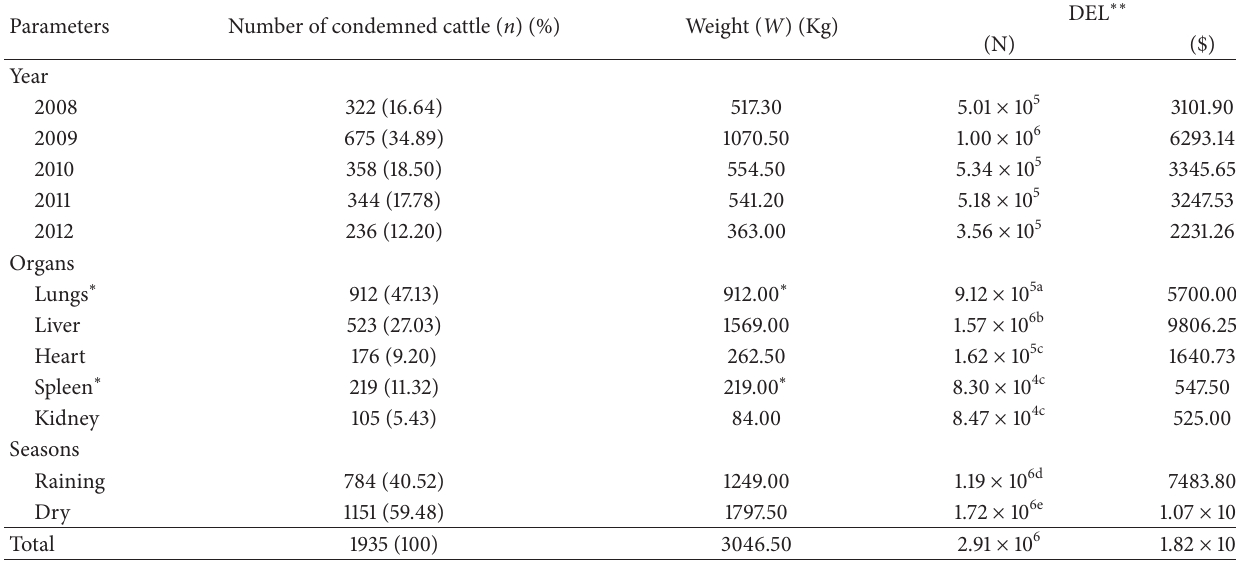
Table 2: Direct economic loss from condemnation of edible organs as a result of detection of tubercle lesion in cattle slaughtered in Makurdi